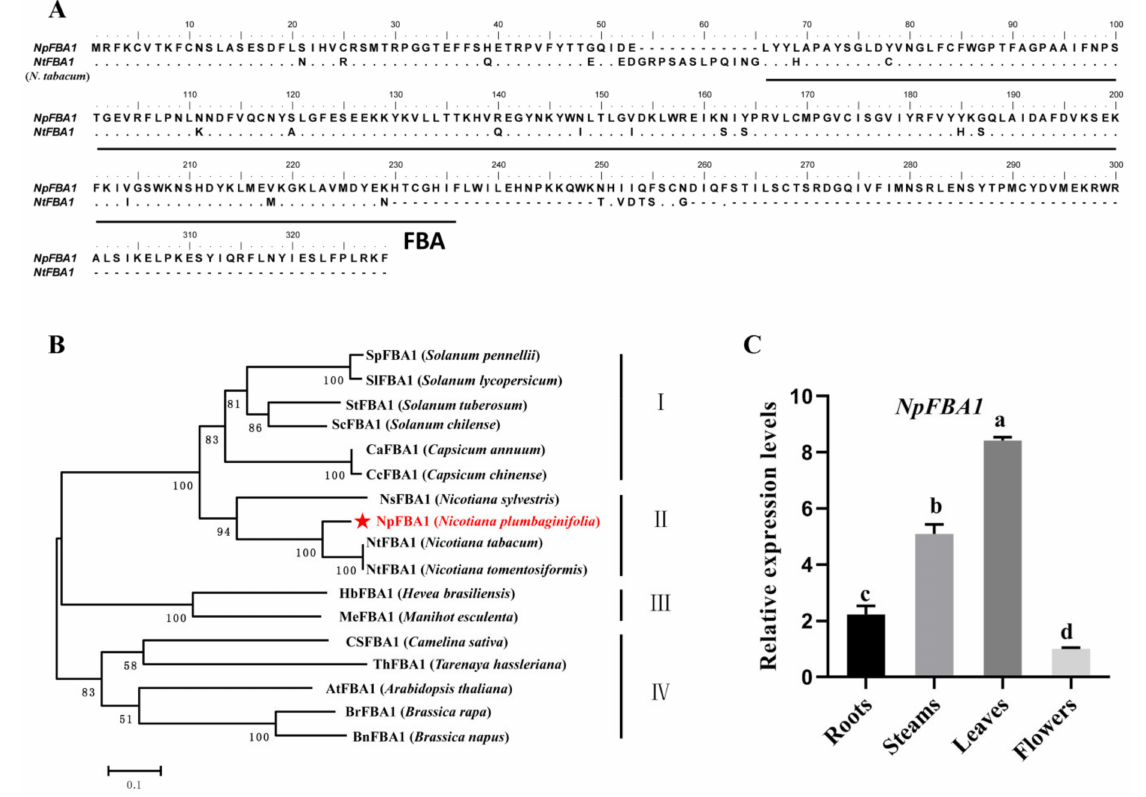
Figure 1. Characterization of NpFBA1 . ( A ) Blast analysis of the NpFBA1 amino acid sequence and NtFBA1 protein sequence, and the black underline represents the FBA conserved domain of NpFBA1. ( B ) Phylogenetic tree of the NpFBA1 protein and FBA proteins in other plants. ( C ) Expression of NpFBA1 in different tissues of N. plumbaginifolia (number of samples, n = 10). The letters above the bars indicate significant differences at p < 0.05 (Duncans multiple comparison